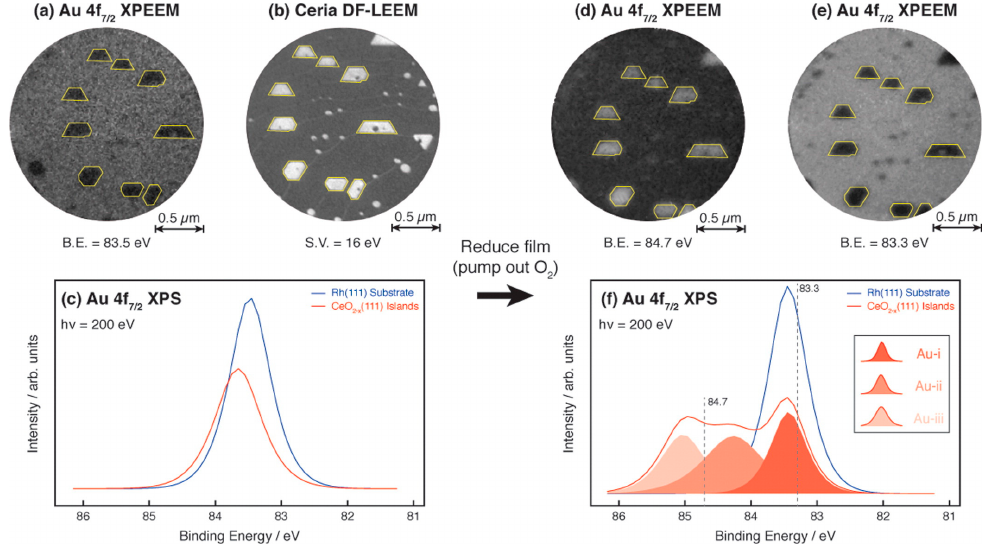
Figure 12. Spectromicroscopy of Au nanoparticles: XPEEM, LEEM and XPS analysis of Au nanoparticles deposited on CeO 1.67 /Rh(111) showing the effect of beam-induced reduction of the ceria. Ceria islands can be discerned in XPEEM and LEEM images. The resolution of the technique allows observing the presence of Au on both the ceria and the Rh support. ( a – c ) analysis under P O = 5 × 10 − 5 Pa; ( d – f ) analysis under UHV conditions. Reprinted with permission from [190]. 2 Copyright 2014, American Chemical